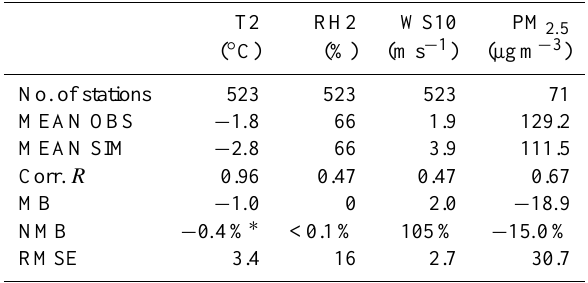
Table 2. Statistical Performance of baseline simulations for meteo-